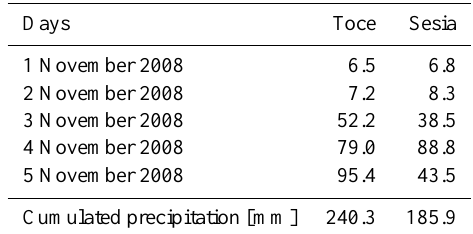
Table 2. Mean areal precipitation cumulated over the Toce and Sesia basins during the 1–5 November 2008